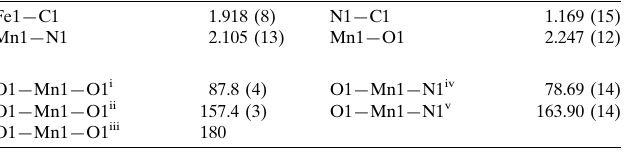
Selected geometric parameters (A˚ , (cid:4)